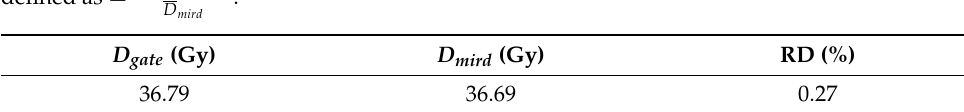
Table 4. Comparison between average absorbed dose values to the liver, calculated from the Gate image ( D gate ) and from the MIRD approach ( D mird ) at the organ level. The relative difference (RD) is − D mird . defined as = D gate D mird D gate (Gy) D mird (Gy) RD (%) 36.79 36.69 0.27